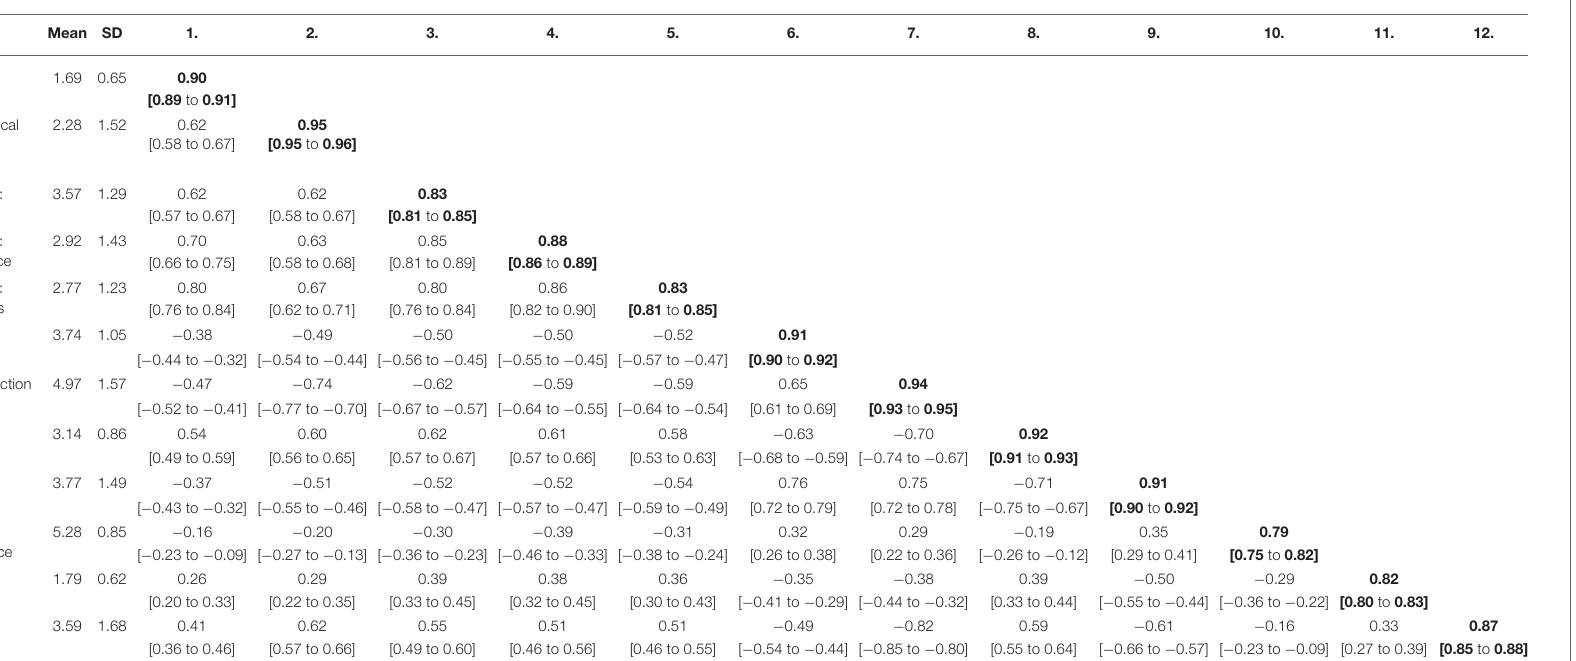
TABLE 2 | Latent means, standard deviations, intercorrelations, and